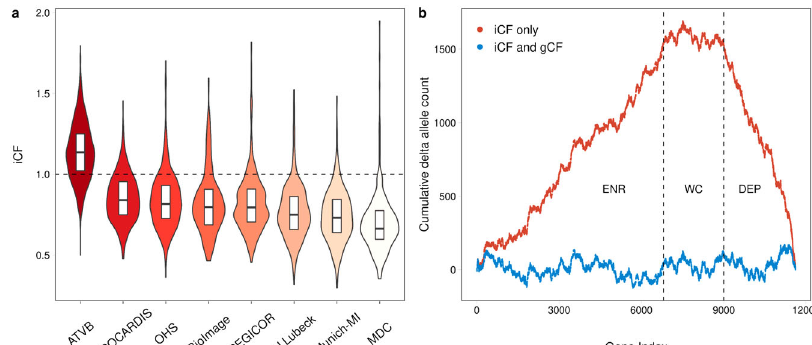
Fig. 4 Correction factor adjustment between studies and across genes. Distribution of iCFs for 6,082 healthy controls from 8 cohorts in MIGen were determined according to rare, pathogenic alleles across all protein-coding genes ( a ). iCF values were calculated as the exome-wide ratio of the sum of per- individual observed allele counts (OAC) to the sum of per-individual expected allele counts in gnomAD (EAC) according to Eq. (5). The violins demonstrate the spread of iCF among all 8 MIGen cohorts. The horizontal line in each boxplot indicates the median iCF values while the top and bottom lines represent the 75th and 25th percentiles of the iCF distribution, respectively. Length of boxplot represents the inter-quartile range of iCF values. Dashed line represents an iCF corresponding to equal total allele counts between a MIGen participant and gnomAD (i.e., iCF = 1). gCF values were computed as the ratio of the sum of OAC to the sum of iCF-adjusted EAC across (1) all individuals and (2) all genes that were organized into one of 50 gene bins according to Eq. (7). Gene bins were ascertained according to quintile of iCF-adjusted EAC and decile of P -value obtained from a rare variant association test (using burden of rare, pathogenic alleles) conducted in the ranking cohort, consisting of the remaining 2730 healthy control participants in MIGen as “ cases ” and gnomAD non-Finnish Europeans as controls. The iCF and gCF-adjusted EAC was thereafter calculated according to Eq. (8). The cumulative delta allele count was calculated from the cumulative sum of the per-gene difference between OAC and either the iCF-adjusted EAC (red points) or iCF and gCF-adjusted EAC (blue points) according to Eq. (9). The cumulative delta allele count demarcates genes that are systematically enriched (ENR), well-calibrated (WC), and depleted (DEP) for rare, pathogenic alleles among MIGen control participants ( b ). The height of the mountain demonstrates the degree of adjustment offered by the iCF to achieve calibration between MIGen controls and gnomAD. Implementing the gCF mitigates residual gene-level biases that cannot be accounted for by the iCF alone. iCF indicates individual correction factor, and gCF indicates gene correction factor. Equations are de fi ned in the “ Methods ” section. Source data are provided as a Source data fi